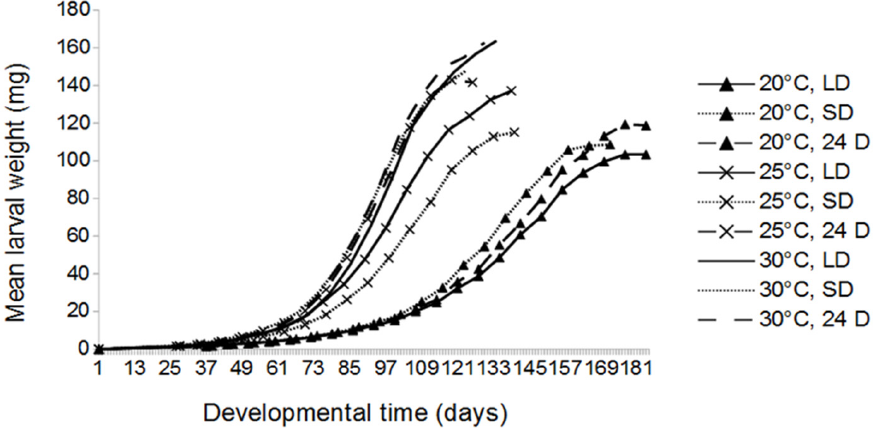
Figure 3. Mean larval weight (in mg) during development (in days) of mealworms at 20 ◦ C, 25 ◦ C, and 30 ◦ C temperatures and LD, SD, and 24D photoperiods. The slopes of curves represent growth rates of all mealworms in one incubator.